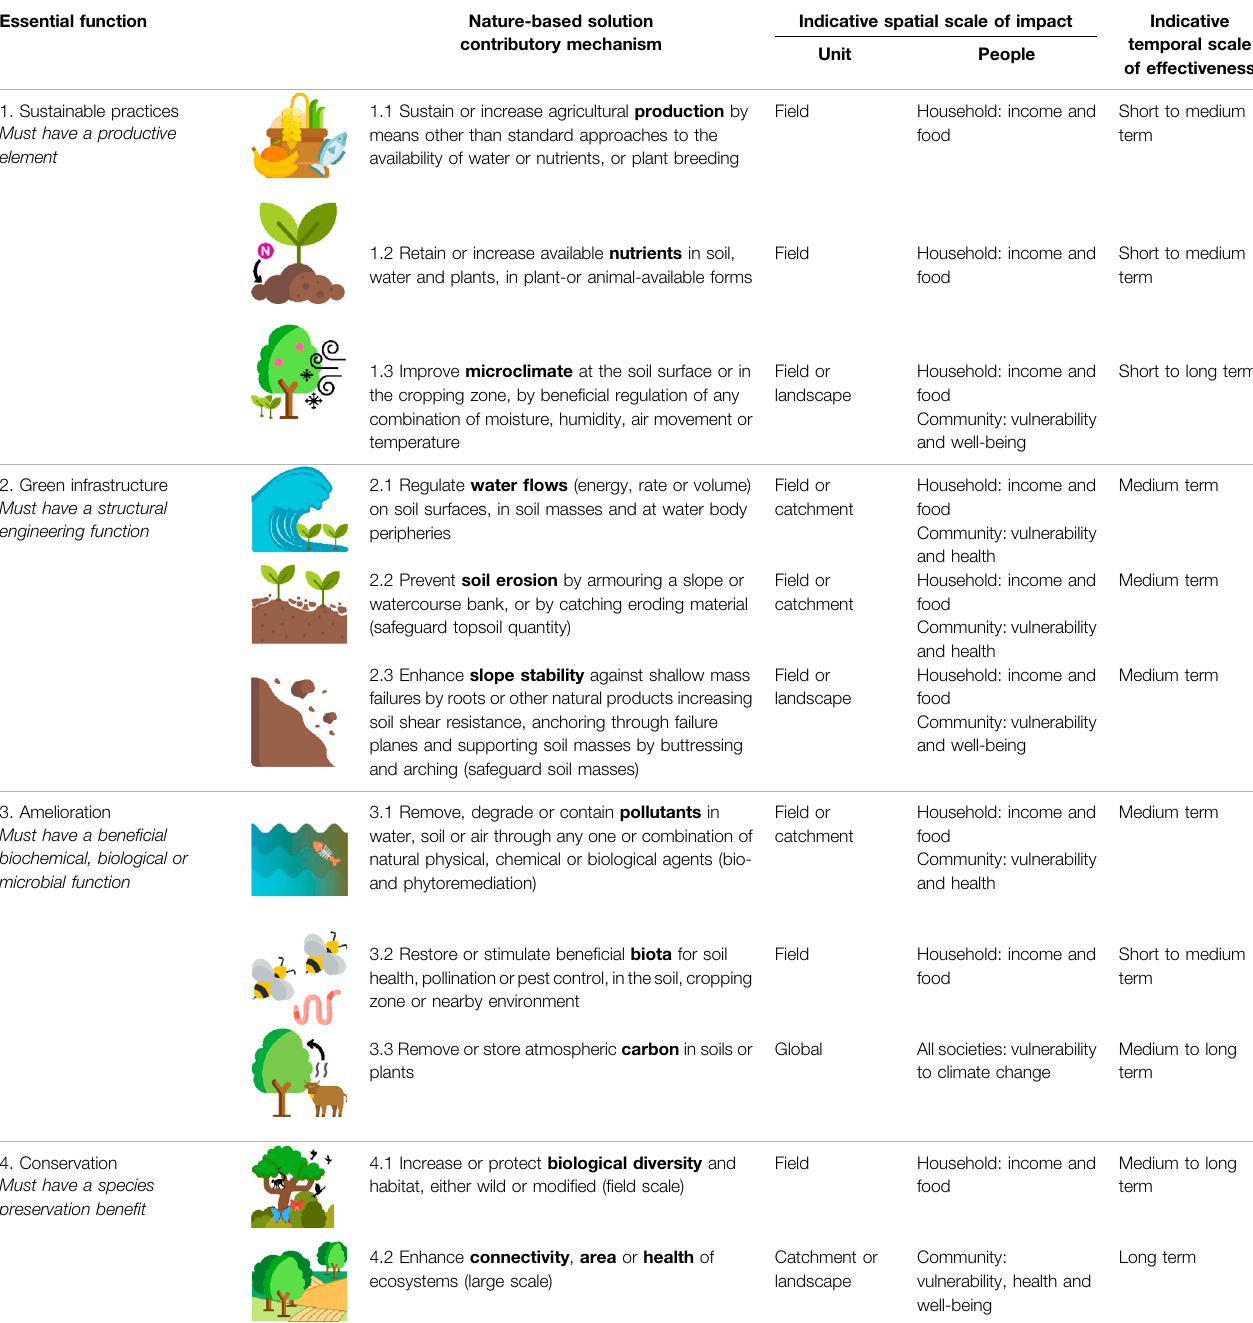
TABLE 2 | The NBS framework for agricultural landscapes. Essential